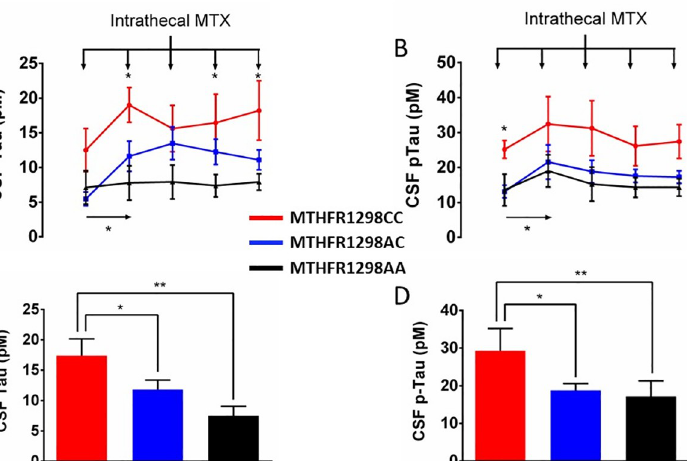
Fig 2. During the induction phase, CSF levels of Tau and pTau are consistently different between the methylenetetrahydrofolate reductase (MTHFR) genotype groups. Panels A-B depict mean CSF Tau (A) and pTau (B) levels ( ± SEM) in subsequent lumbar puncture (LP) samples (LP1: diagnosis, LP2-5: Induction) in the three genotype groups. Vertical arrows at the top of each figure represent the intrathecal methotrexate (MTX) injections after each LP. The first MTX administration produced a significant rise in CSF Tau and pTau levels. Notably, biomarker levels were already higher in the MTHPR1298CC group prior to MTX injection (LP1). Panels C-D depict CSF Tau (C) and pTau (D) levels during the induction phase (LP2-5) in the three genotype groups. Post-MTX, pooled Tau and pTau levels were highest in MTHFR1298CC homozygotes, intermediate in heterozygotes. MTHFR genotype is indicated with color in all panels (red: MTHFR1298CC, blue: MTHFR1298AC, black: MTHFR1298AA). Appropriate ANOVA was followed by post-hoc LSD testing with � p < 0.05; �� p < 0.010; ��� p < 0.001.